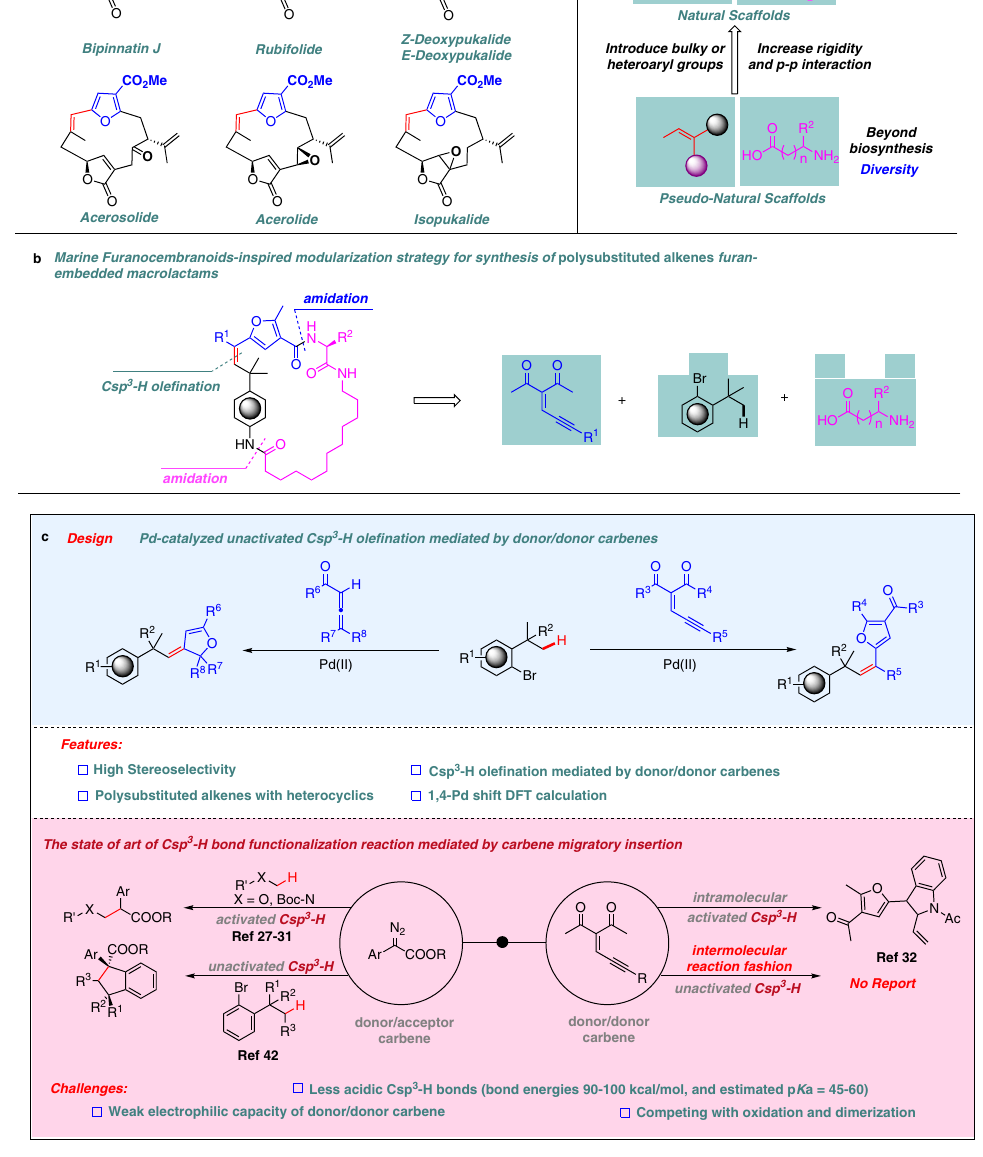
Fig. 1 A modular strategy for the synthesis of natural furanocembranoids-like compounds via intermolecular Pd-catalyzed unactivated Csp 3 – H ole fi nation mediated by donor/donor carbenes. a Marine cembranoids or furanobutenolide-based cembranoids which bear the alkene-substituted furan scaffold. b Modular strategy for the synthesis of polysubstituted alkene furan-embedded macrolactams. c The design of Pd-catalyzed unactivated Csp 3 ‒ H ole fi nation mediated by donor/donor